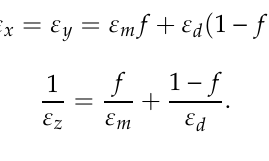
Figure 5. Permittivity ε ( a ) and permeability µ ( b ) versus the filling fraction f ( ε 0 and µ 0 are the units).